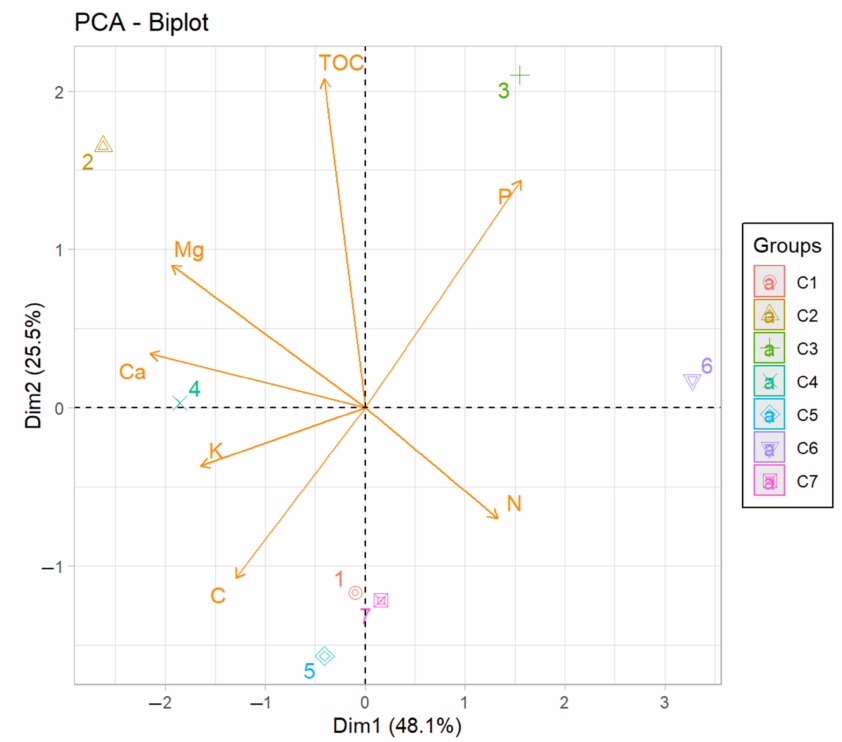
Figure 5. Principal component analysis (PCA) of composts based on nutrient and humic substances’ (HSs) TOC concentrations. Axis 1 explains 48.1% of the variance, and axis 2 explains an additional 25.5% of the variance. Compost labels according to the target waste: C1 fish waste; C2 horse manure; C3 sewage sludge; C4 green waste; C5 kitchen biowaste; C6 H. illucens frass; and C7